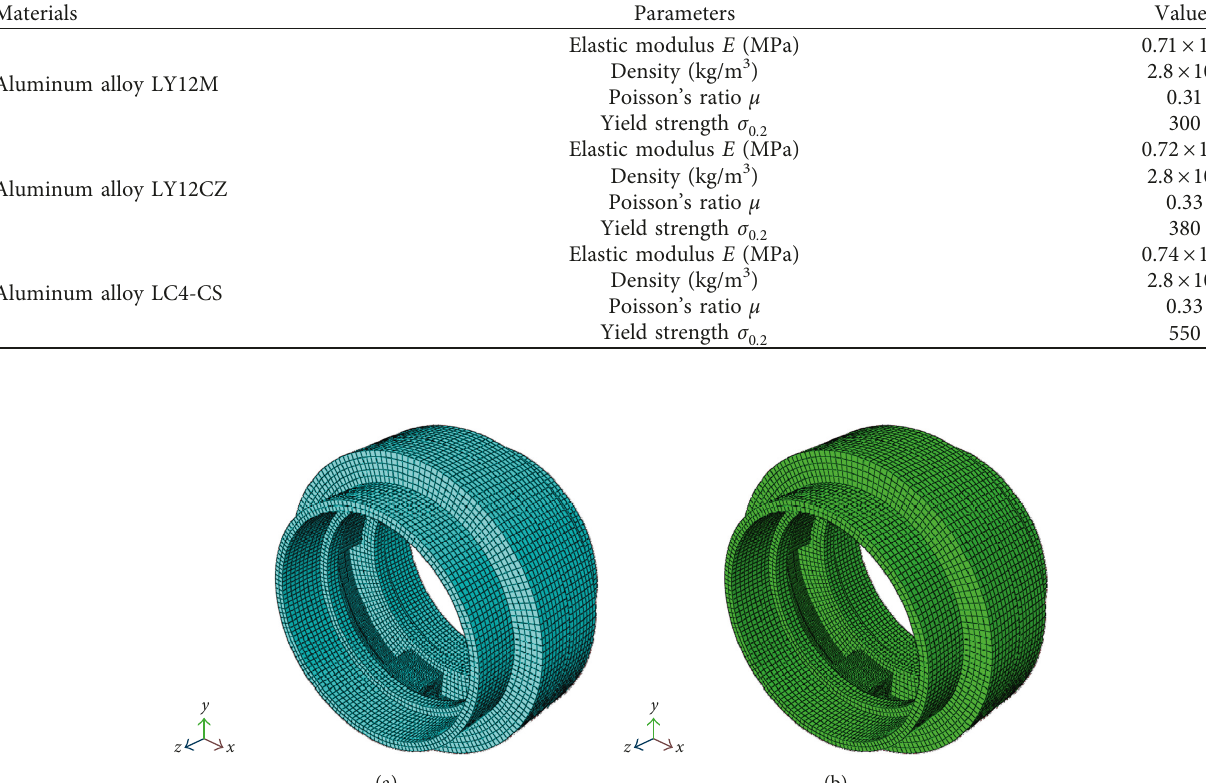
Table 2: Mechanical properties of different aluminum alloys.